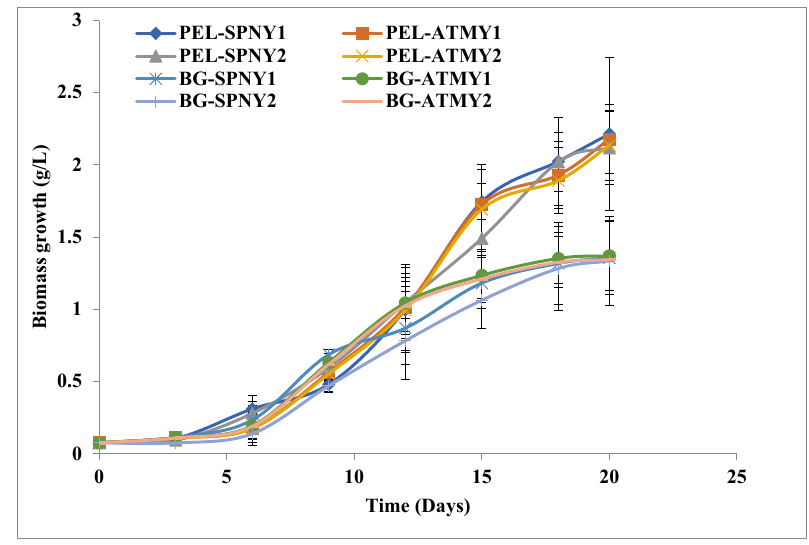
Figure 3. Growth of C. pyrenoidosa at solar inclination angles of 32.9°.